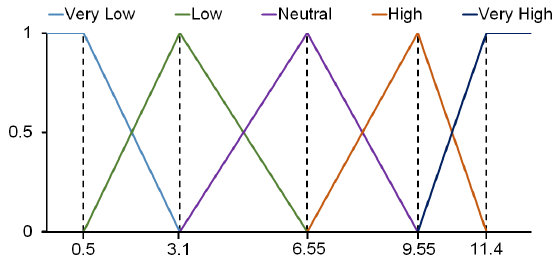
Figure 1. Linguistic labels for the alcohol level data